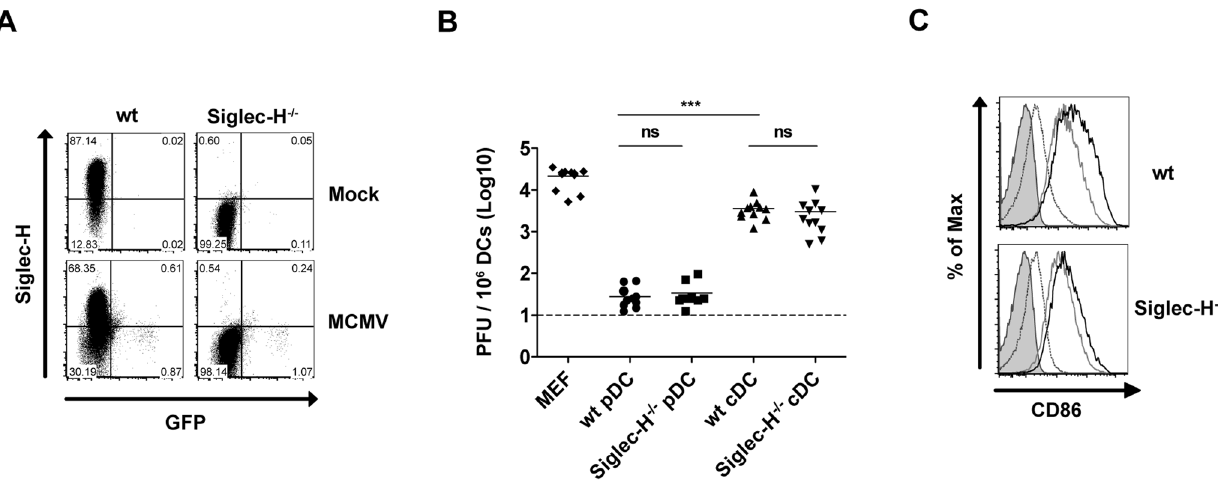
Figure 4. Siglec-H receptor does not play a role in pDC infection. Flt3-L derived CD11c + B220 + pDCs and CD11c + B220 2 cDCs were sorted from BMDC cultures of wt and Siglec-H 2 / 2 mice. DCs were mock treated with PBS or MCMV-GFP infected at MOI 2. ( A ) Representative FACS plots show Siglec-H expression and MCMV-GFP expression at 24 h p.i. ( B ) Quantification of the viral titers per 10 6 DCs or MEFs at 24 h p.i. ( C ) Representative histogram plots of CD86 expression on wt and Siglec-H 2 / 2 sorted pDCs (live cell gate) at 24 h p.i. (gray bar=isotype control, gray dashed line=mock treatment, gray solid line=CpG-A treatment, dark bold line=MCMV infection). Data are from one of three individual experiments with similar results. ns=not significant *** p , 0.001, Students